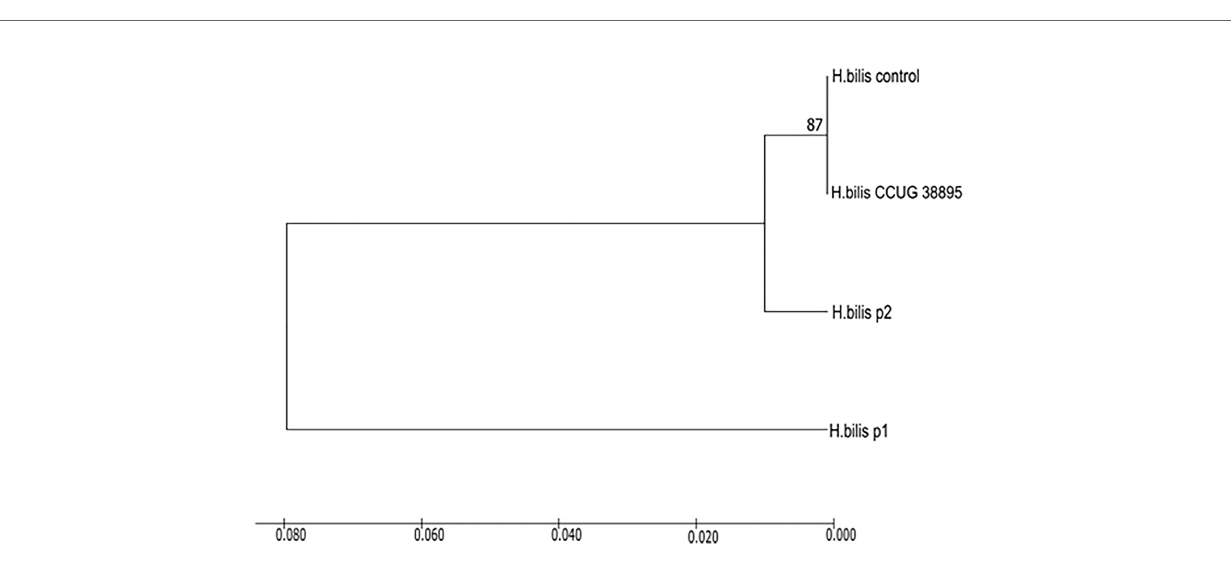
FIGURE 6 | Phylogenetic tree based on partial 16S rRNA sequences showing Case 1 and Case 2 = P1 and P2, respectively, within the radiation of H. bilis strains. Case 2 clusters with H. bilis strain CCUG38895 and control strain (ATCC 51630) used in the diagnosis. The numbers at the nodes indicate the level of bootstrap support (%) based on UPGMA method analyses of 500 bootstrap replications, and percentages are indicated on nodes. The scale bar indicates an 8.0% difference in gene sequence, and distances were computed with the maximum composite likelihood